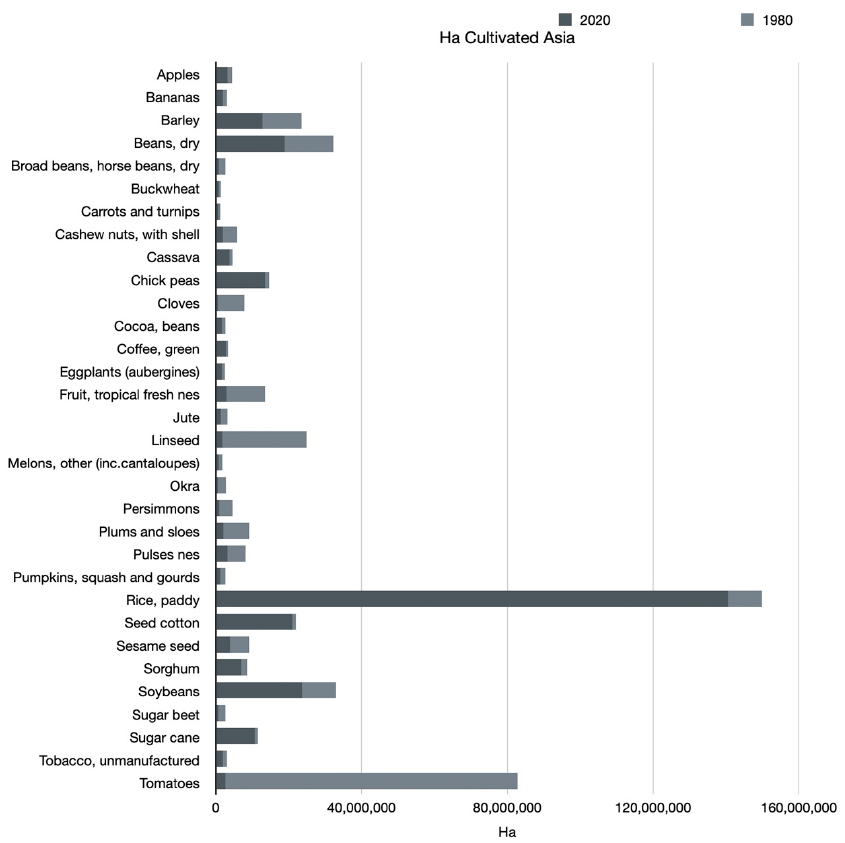
Figure 2. Crops production with an extension higher than 100,000 Ha in Asia, adapted from [25].